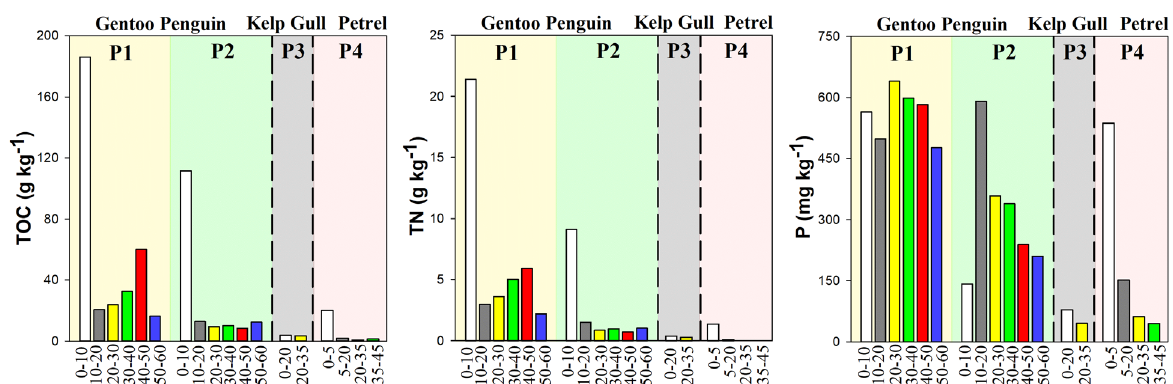
Figure 3. Contents of total organic carbon (TOC), total nitrogen (TN), available phosphorus (P) from different soil depths (cm) under influence of gentoo penguins (P1 and P2) in the Livingston Island, and by kelp gulls (P3) and giant petrels (P4) in the Nelson Island,